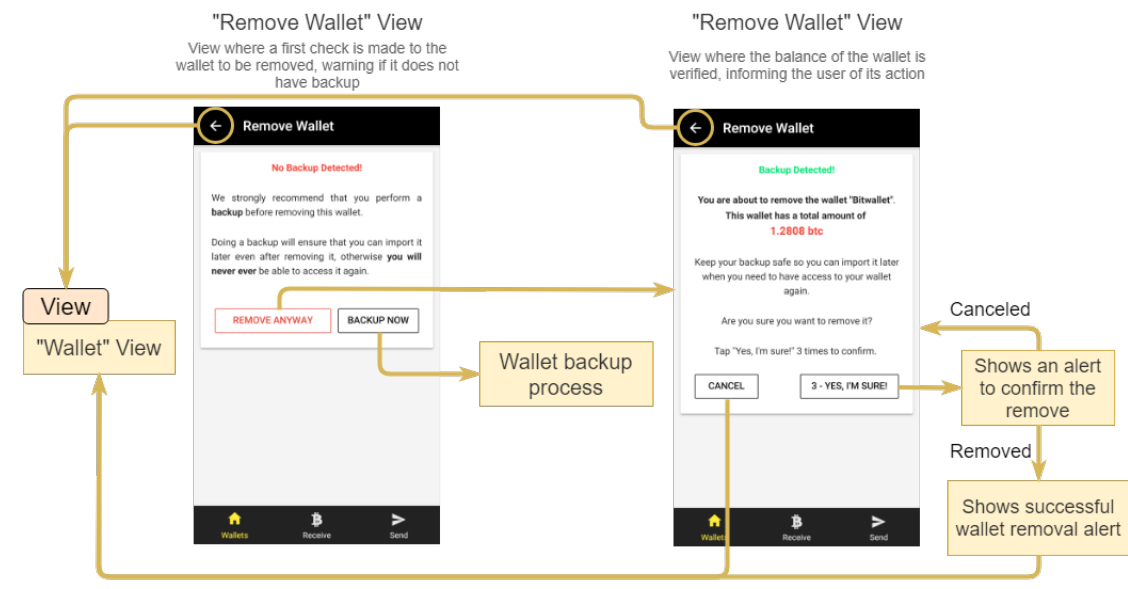
Figure 10. Navigability diagram of the process of removing a wallet.